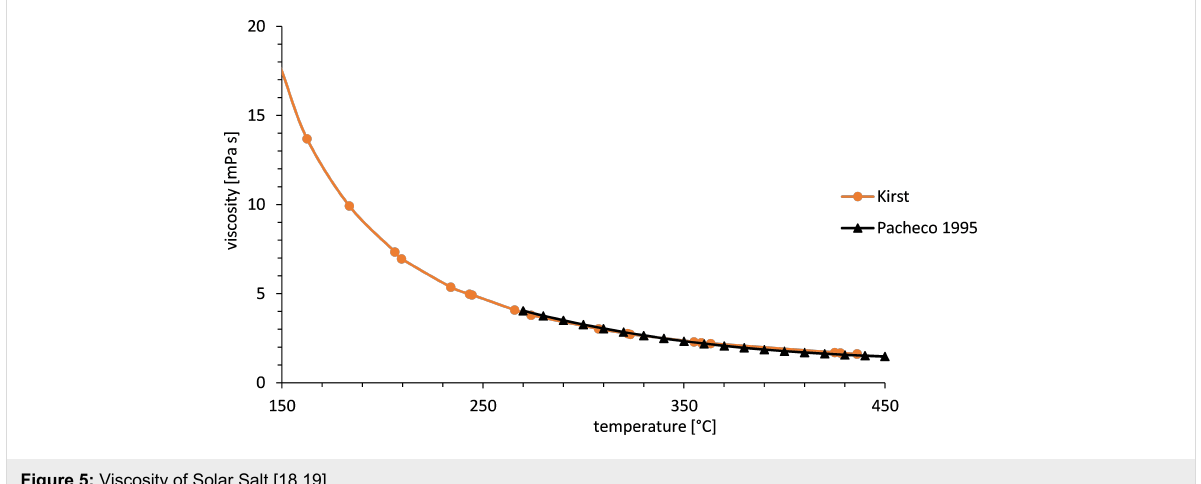
Figure 5: Viscosity of Solar Salt [18,19].